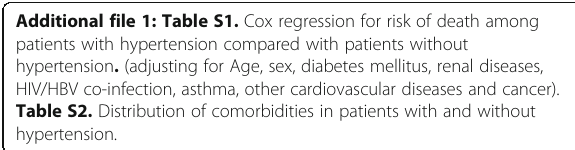
Abbreviations ACE: Angiotensin-converting enzyme; ARBs: Angiotensin receptor blockers; HTN: Hypertension; HTN + : Hypertension with other comorbidities; HR: Hazard ratio; aHR: Adjusted hazard ratio Supplementary Information The online version contains supplementary material available at https://doi.